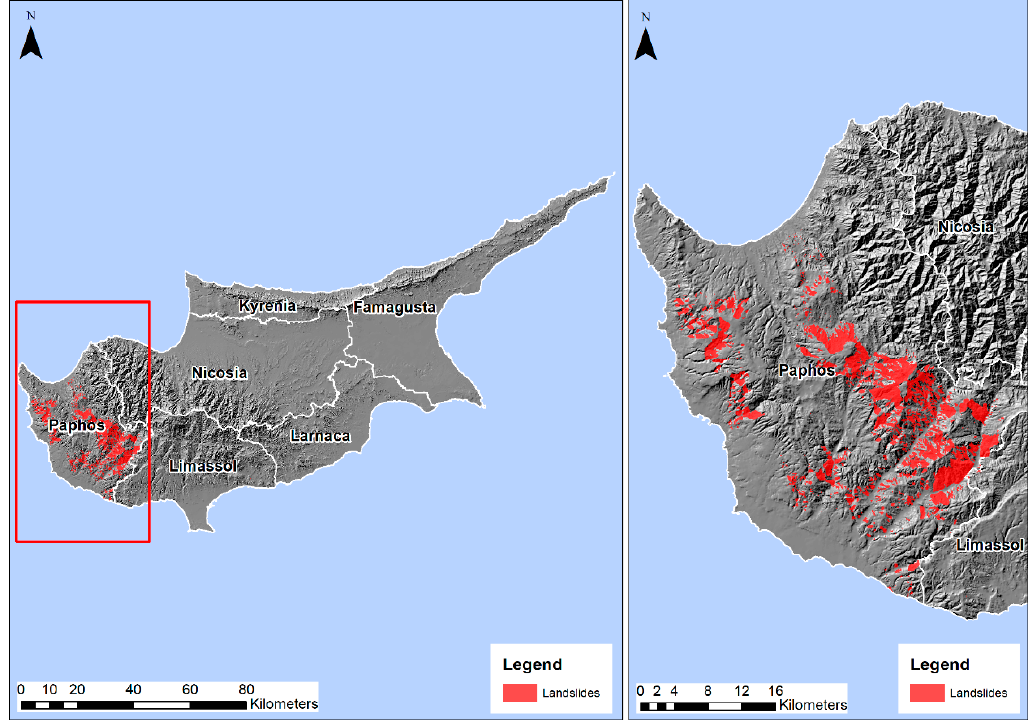
Figure 2. Landslide inventory map of Cyprus. Landslides occur mostly on the western part of the island. Digitized map based on data provided by the Cyprus Geological Survey Department.